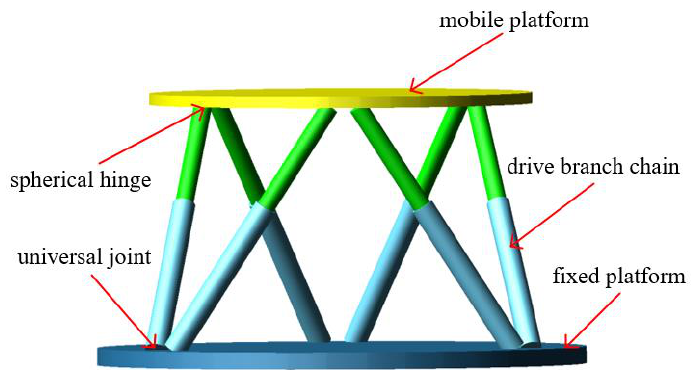
Figure 3. Parametric model of the 6-UPS parallel mechanism.